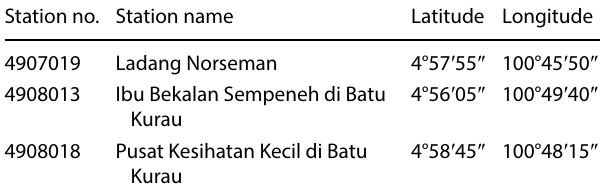
Table 1 List of rainfall stations Station no. Station name